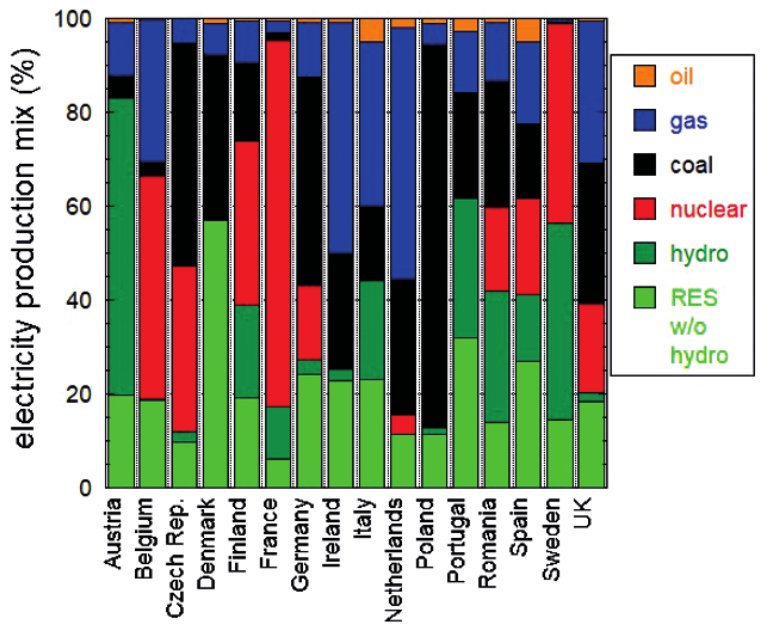
Fig. 7. – Sources of electricity production of European